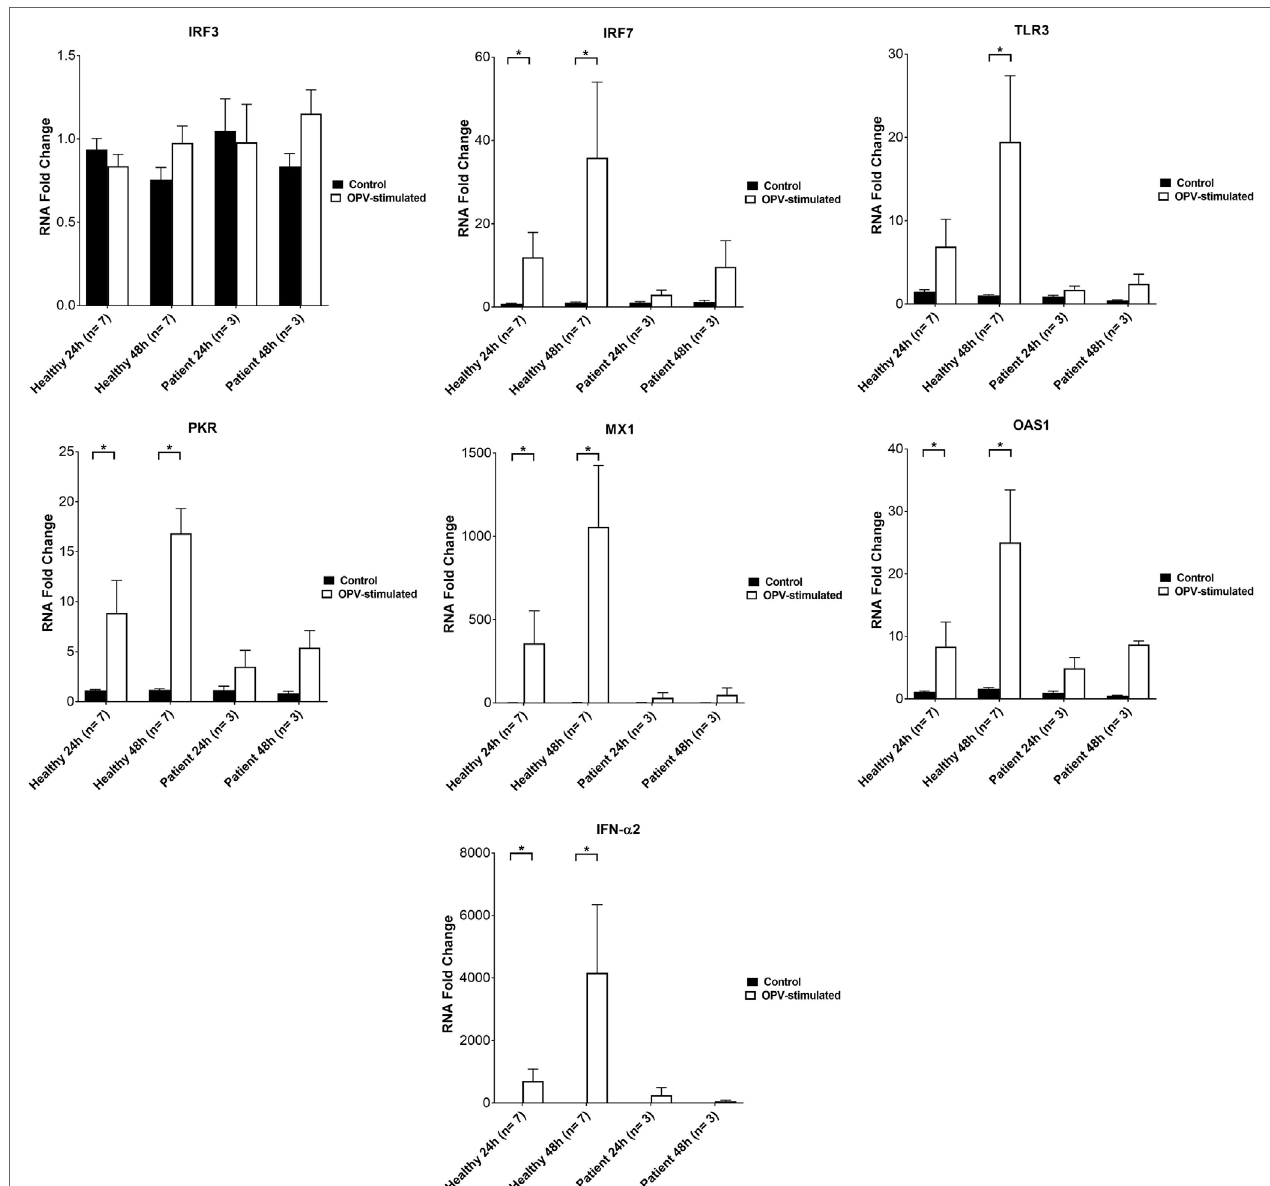
FigUre 5 | IRF3 , IRF7 , TLR3 , PKR , MX1 , OAS , and IFN- α 2 RNA levels in MoDCs from healthy controls ( n = 7) and X-linked agammaglobulinemia patients ( n = 3) after 0 to 48 h post-infection. MoDCs were treated with OPV at multiplicity of infection of 1. Open bars represent RNA fold changes in MoDCs treated with OPV; filled bars represent RNA fold changes in MoDCs treated with RPMI. Fold change of RNA at 24 and 48 h compared to 0 h post-infection was calculated by the “ ΔΔ Ct” method using GAPDH as endogenous control. Abbreviations: IRF, interferon regulatory factor; TLR, toll-like receptor; PKR, protein kinase R; MX1, MX dynamin-like GTPase 1; OAS1, 2 ′ -5 ′ oligoadenylate synthetase 1; IFN, interferon; GAPDH, glyceraldehyde-3-phosphate dehydrogenase. Data represented as mean ± SEM. Statistics were analyzed by Wilcoxon matched-pairs signed rank test. * p <